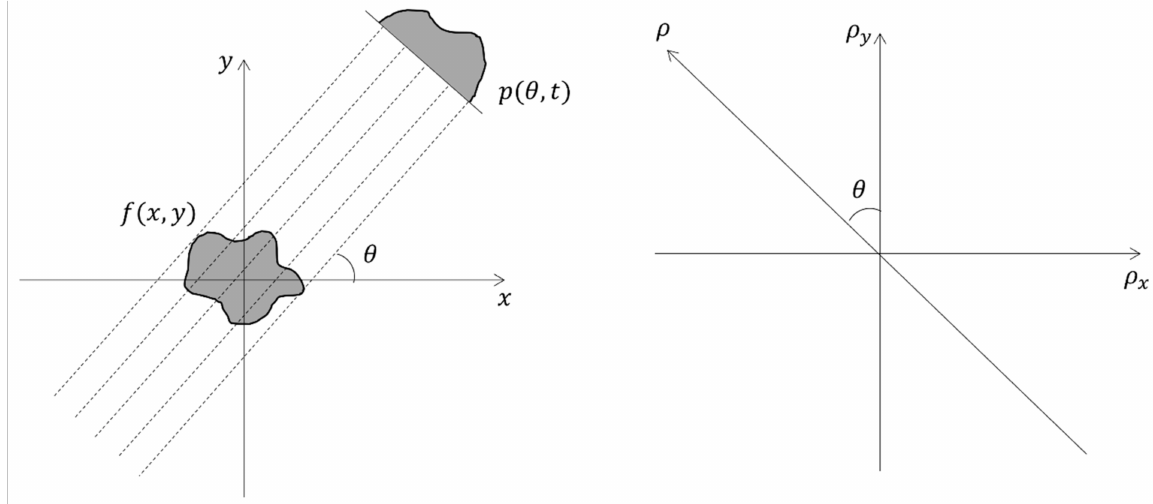
Figure 2. Tomographic system assumed for descriptive purposes. ( Left ) Illustration for the Radon transform theorem. ( Right ) Illustration for the Fourier slice